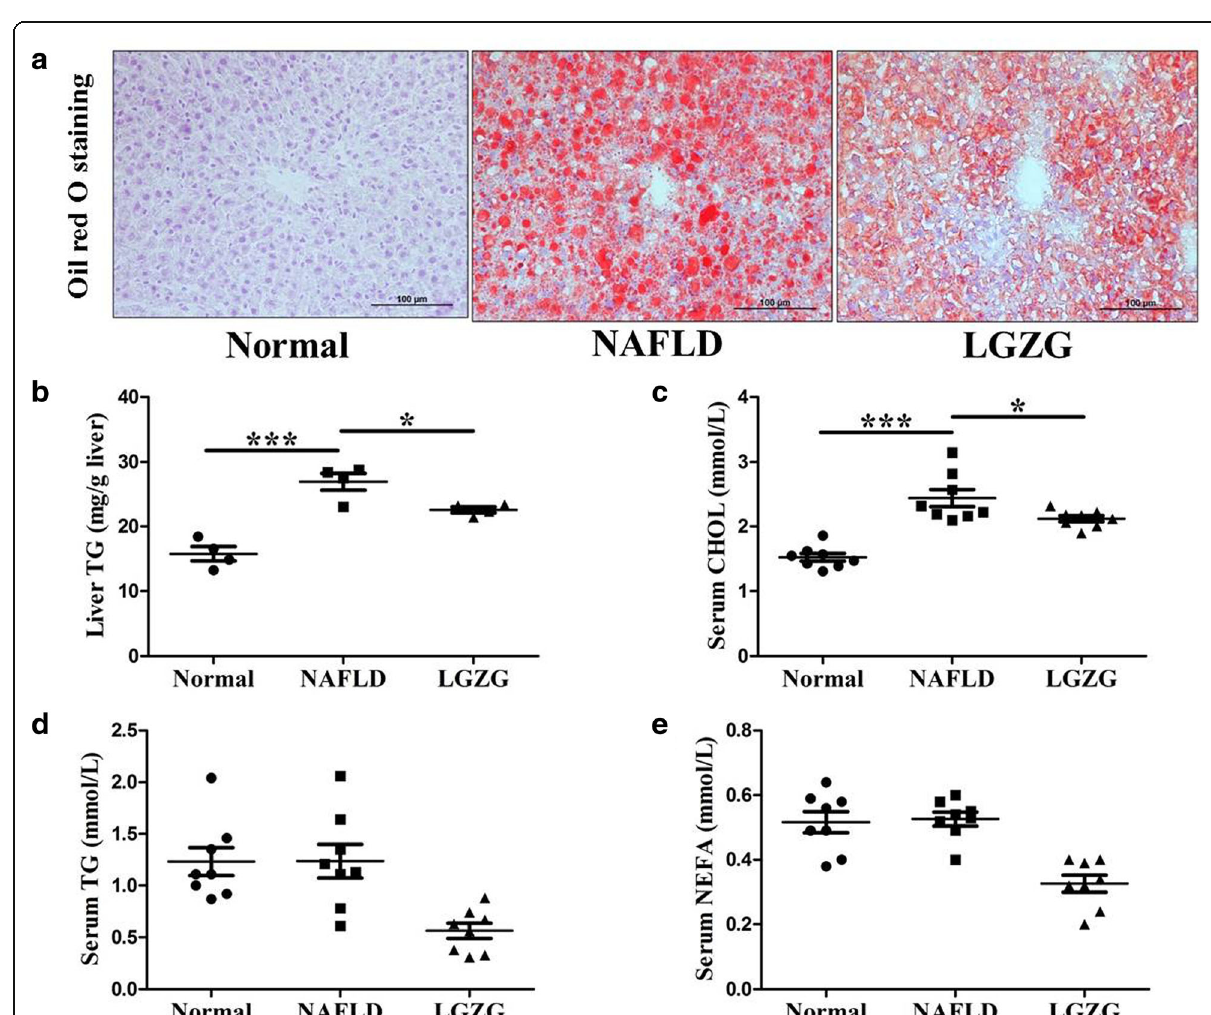
Fig. 1 LGZG decoction alleviated hepatic steatosis and dyslipidemia in NAFLD rats. Liver sections were stained with oil Red O ( a ) (image magnification ×200), ( b ) liver TG content was detected ( n =4 per group), ( c ) Serum CHOL, ( d ) TG, ( e ) NEFA were analyzed ( n =8 per group). Data were presented as means ± SEM. * P <0.05, *** P